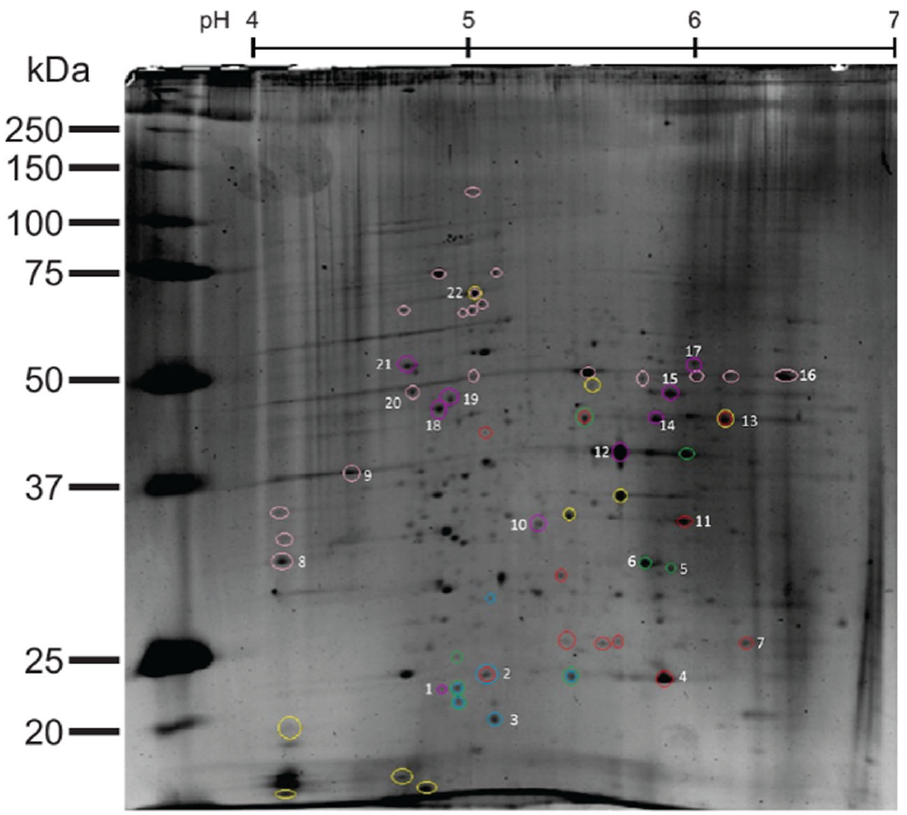
Figure 4. 2D SDS-PAGE cell extract proteome analysis of M. microti strains. Circled proteins were selected based on the fluorometric analysis according to the differential expression: M. microti -PMV261 (red circles), M. microti -PstS-1 (blue circles) and M. microti -Ag85 (green circles). Numbered proteins were sequenced using MS/MS (Table 2). Unnumbered pink and yellow circled spots represent glycosylated proteins.